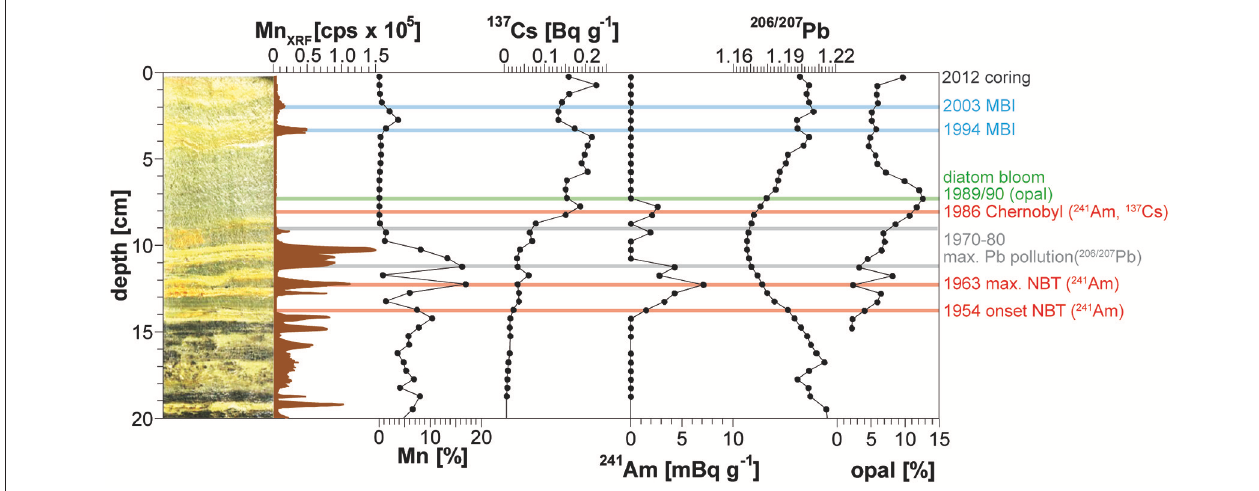
FIGURE 7 | Photograph, Mn counts (X-ray fluorescence core scanning), Mn contents (inductively coupled plasma optical emission spectrometry), activities of 137 Cs and 241 Am, 206 / 207 Pb values, and biogenic opal contents of the short core taken in August 2012 close to station 271 in the central Gotland Basin. The data were used to identify time markers for event-stratigraphic dating of the sediment core (Supplementary